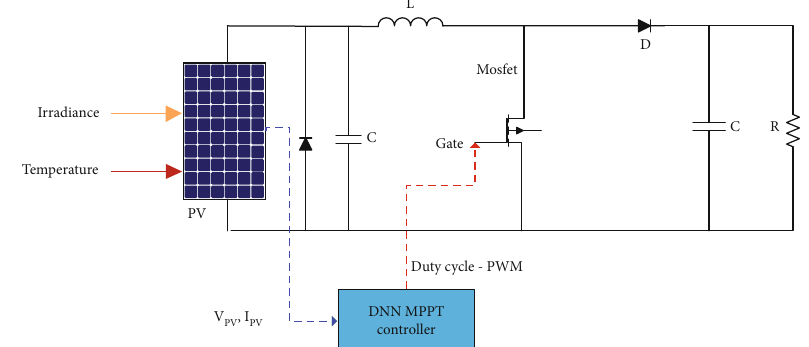
Figure 2: Proposed DNN-based MPPT algorithm.